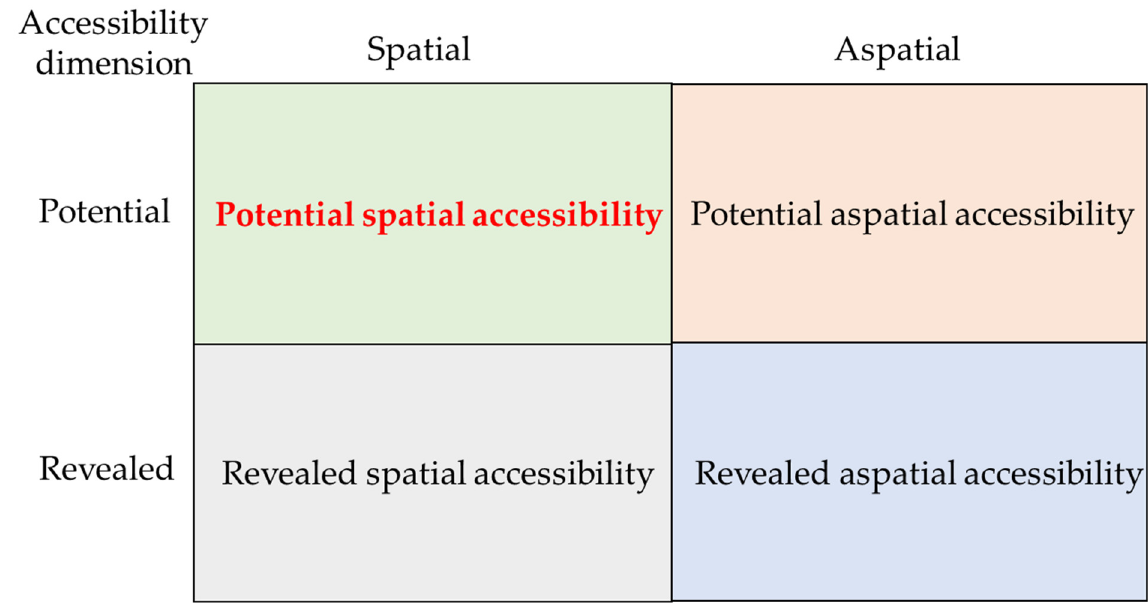
Figure 1. The conceptual framework for accessibility .